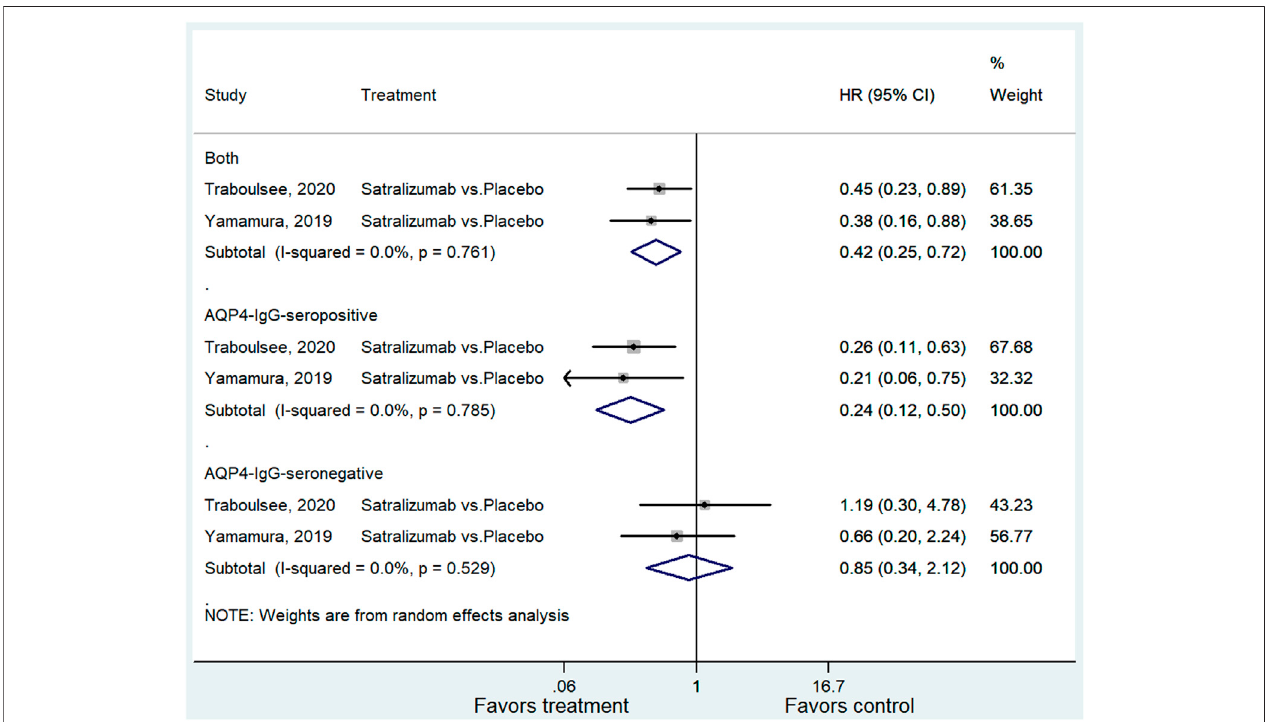
FIGURE 3 | Subgroup analysis for the ef fi cacy of satralizumab in each group of patients.